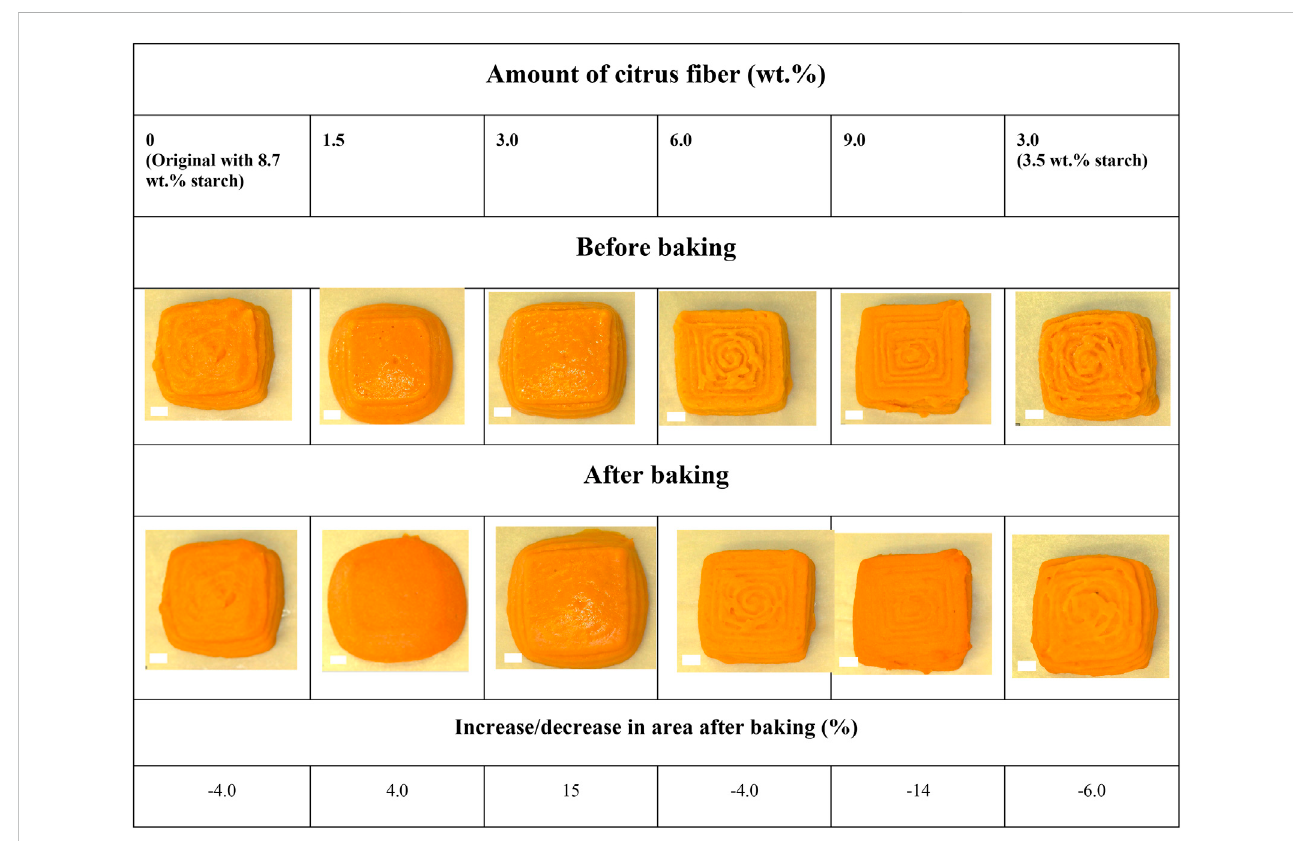
FIGURE 4 3D-printed cubes using the original and fi ve modi fi ed formulations before and after baking, the white scale bar to the left in each image correspond to 5 mm. A comparison of the area in respect to after baking was conducted and is shown in the bottom